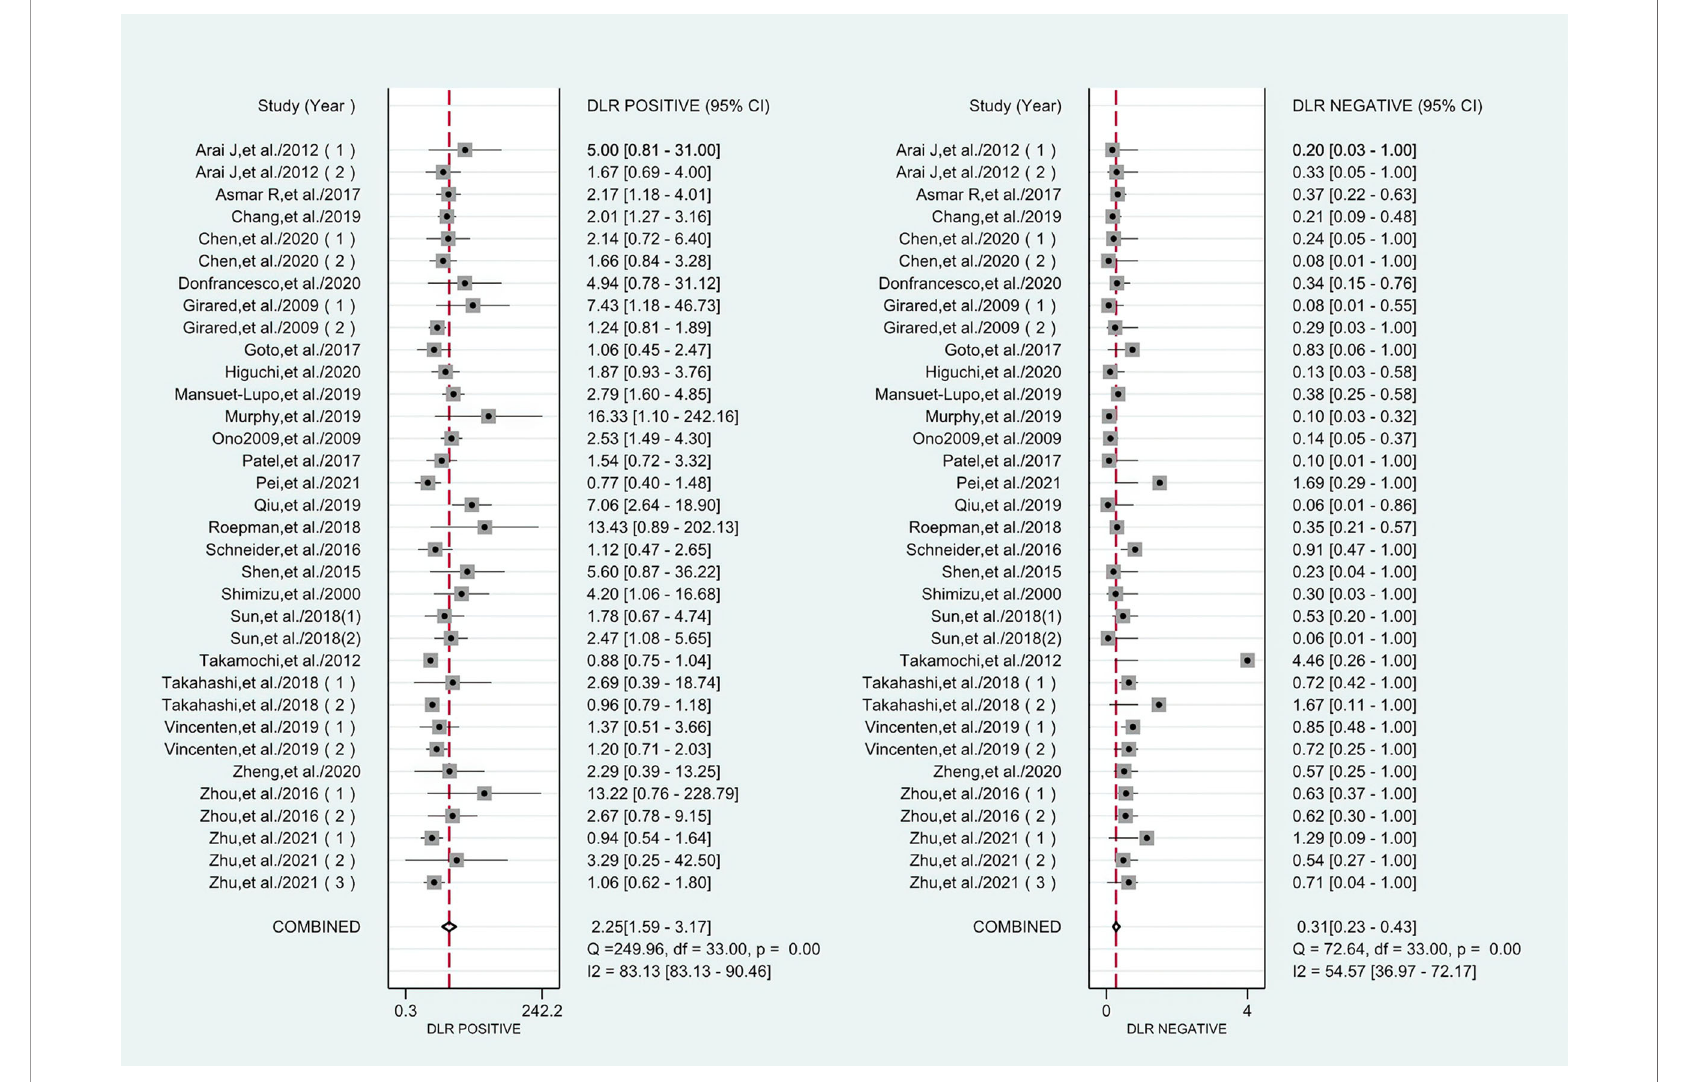
FIGURE 6 | Forest plots of PLR and NLR for histology in the differential diagnosis of MPLC and